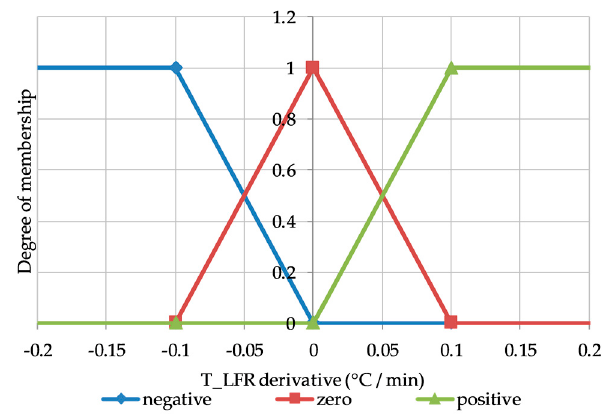
Figure 5. Derivative component of the first fuzzy logic controller.